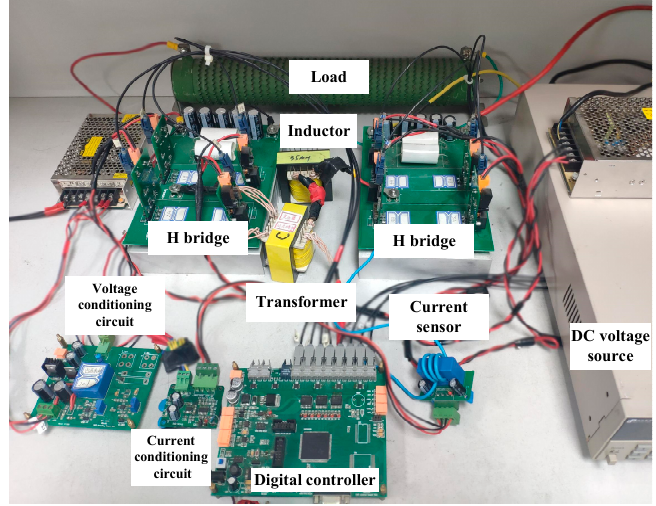
Figure 13. The inductor current under different load resistance.